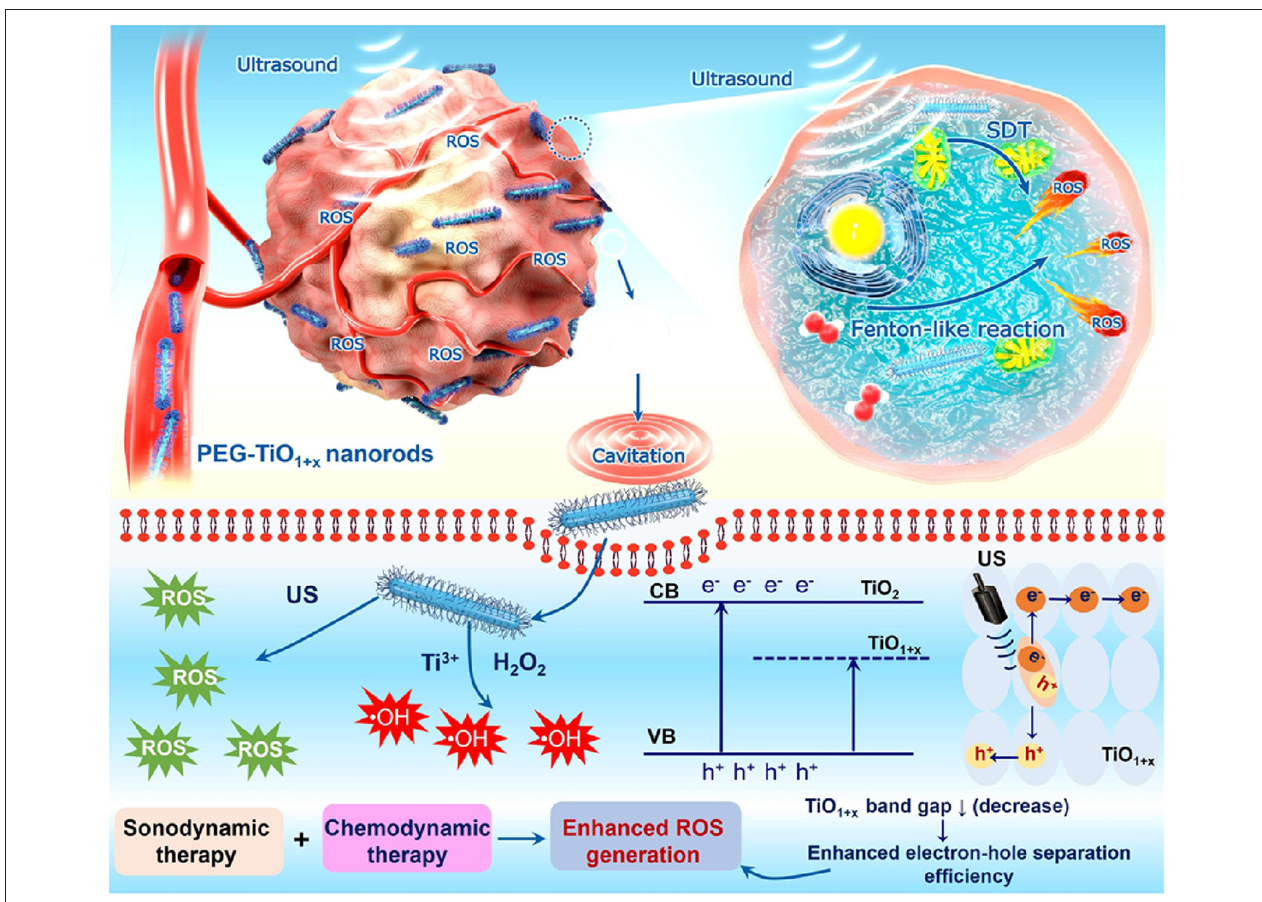
FIGURE 8 | Application of PEGylated titanium monoxide nanorods (TiO 2 NRs) in sonodynamic therapy. Oxygen-deficient TiO 2 NRs have shown higher reactive oxygen species (ROS) generation upon ultrasound irradiation. Reproduced with permission (Wang et al., 2020d) Copyright © 2020, American Chemical Society